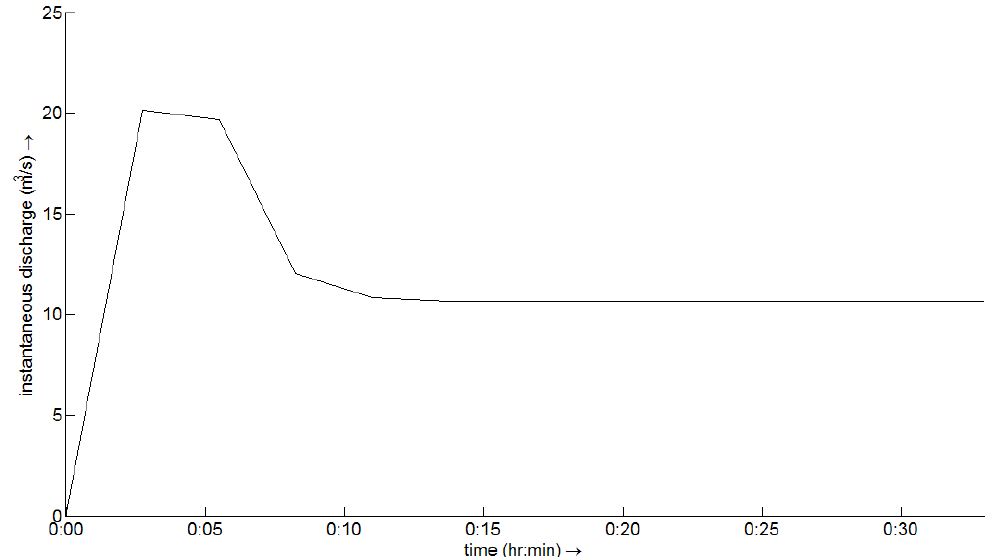
Figure 16. Instantaneous discharge vs. time across C-S FG for HDS scenario.